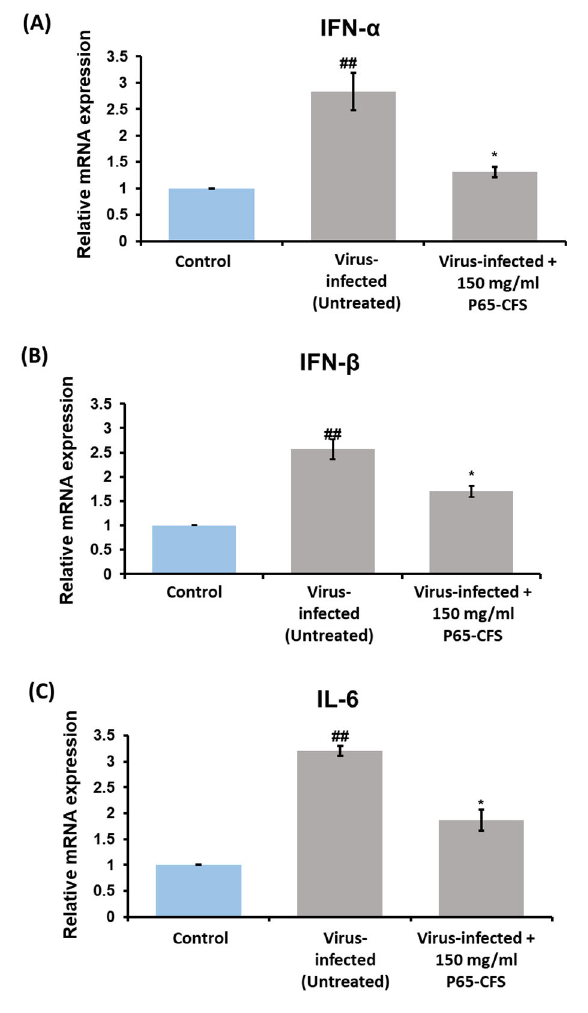
Figure 5. Modulation of the expression of inflammatory markers in HEK 293 cells after infection in the presence and absence of L. sakei Probio65 cell ‐ free supernatant (P65 ‐ CFS). The expression of ( A ) IFN ‐α , ( B ) IFN ‐β , and ( C ) IL ‐ 6 were measured using quantitative PCR and normalized to GAPDH. All the experiments were conducted in triplicate and statistical analysis were performed using the t ‐ test. Analysis of each sample was performed in triplicate, and data are represented as the means ± SD of three independent experiments. * p < 0.05 compared with virus ‐ infected cells; ## p < 0.05 compared with the control.